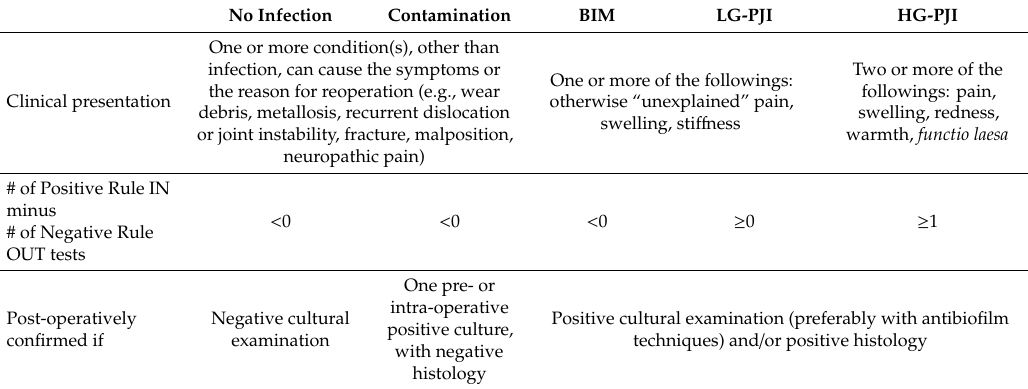
Table 3. WAIOT proposed definition of peri-prosthetic joint infection